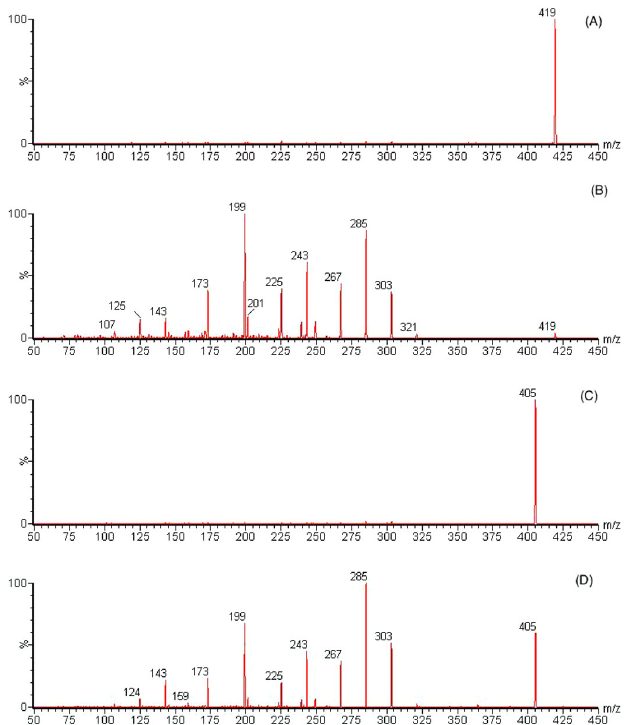
FIGURE 1 - Ion mass spectra [M+H] + : (A) simvastatin precursor ion, (B) simvastatin product ion, (C) lovastatin precursor ion, and (D) lovastatin product